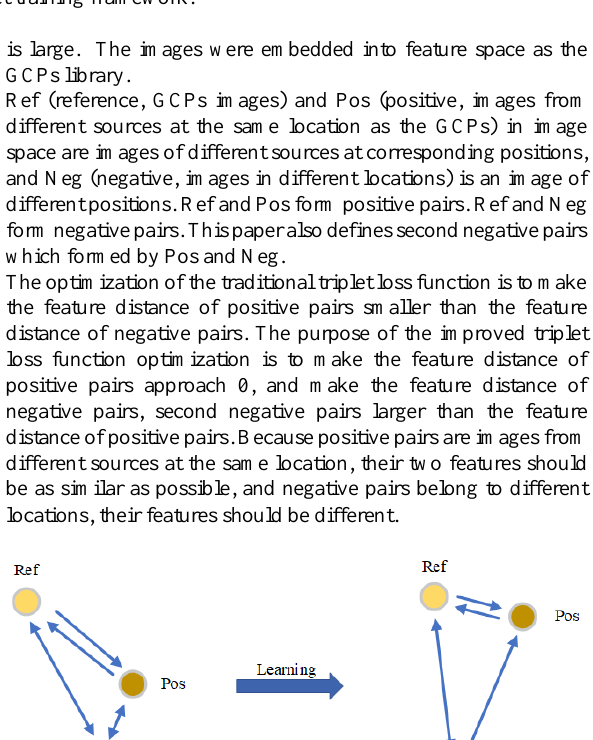
Figure 1. Improved triplet training framework.